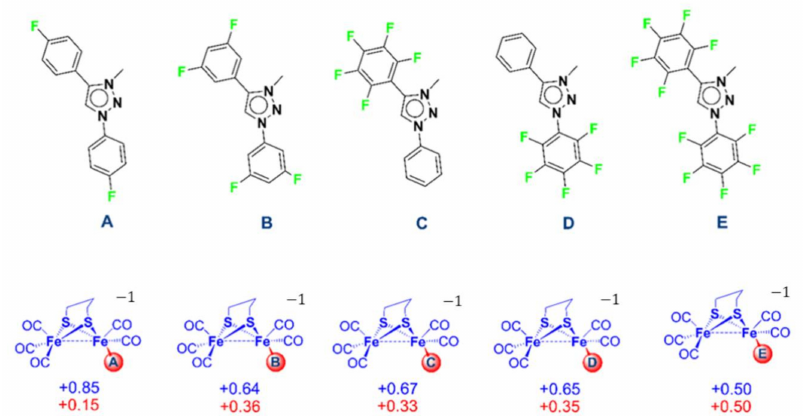
Figure 5. Structure of the Pmpt ligand variants tested ( A – E , top), with the corresponding spin density values (in electrons, bottom) calculated for the anionic form of the corresponding mono-substituted complexes (spin density on the modified Pmpt ligands is reported in red, while the one on the rest of the complex comprising the Fe 2 S 2 core is in